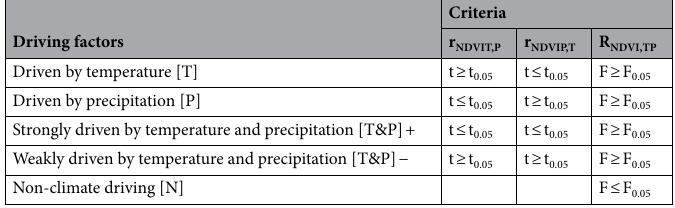
Table 1. Criteria for classifying dominant climate